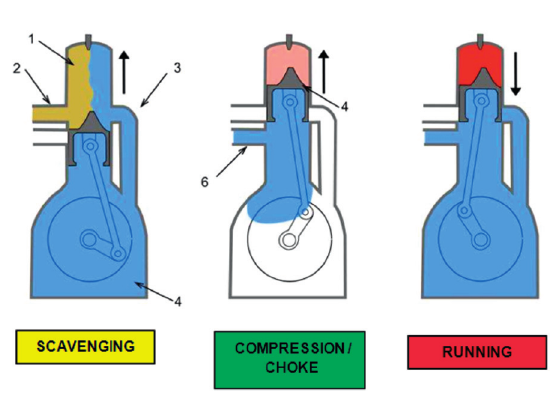
Fig. 1. Two-stroke engine work cycle